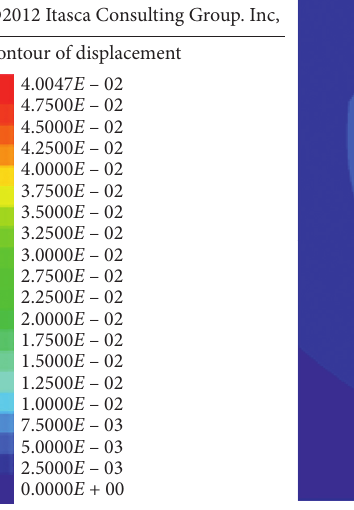
Figure 15: Cloud map of the roadway surrounding rock displacement under the new support scheme.